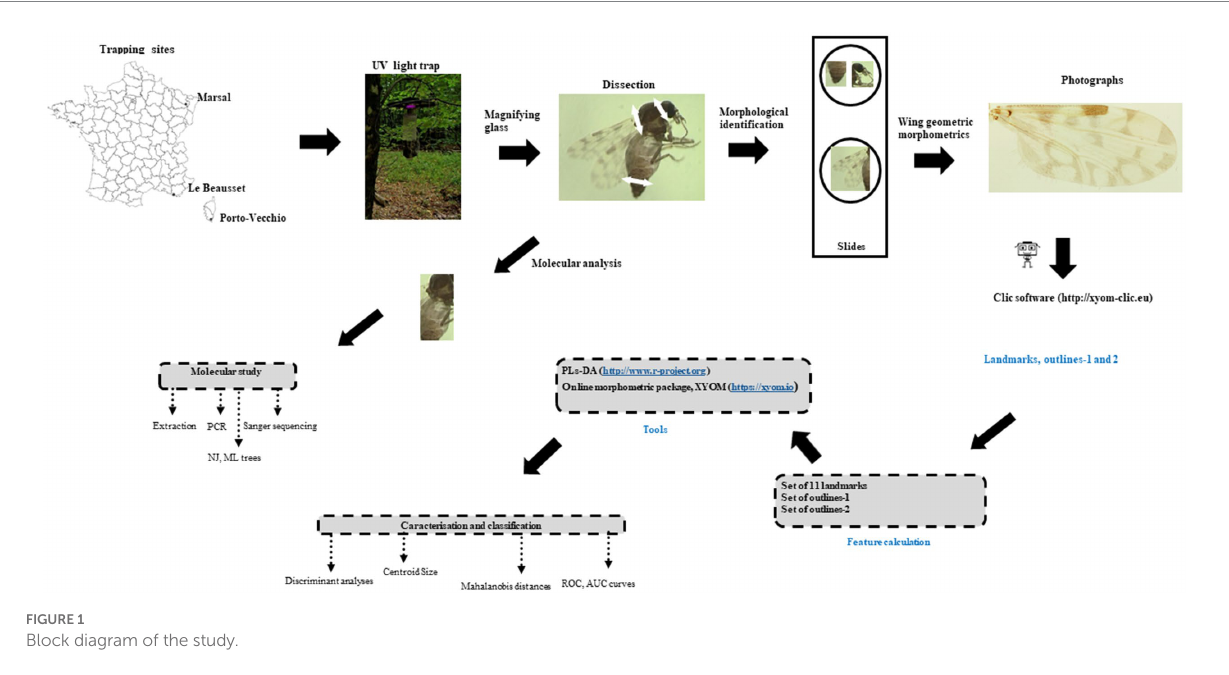
FIGURE 1 Block diagram of the study.